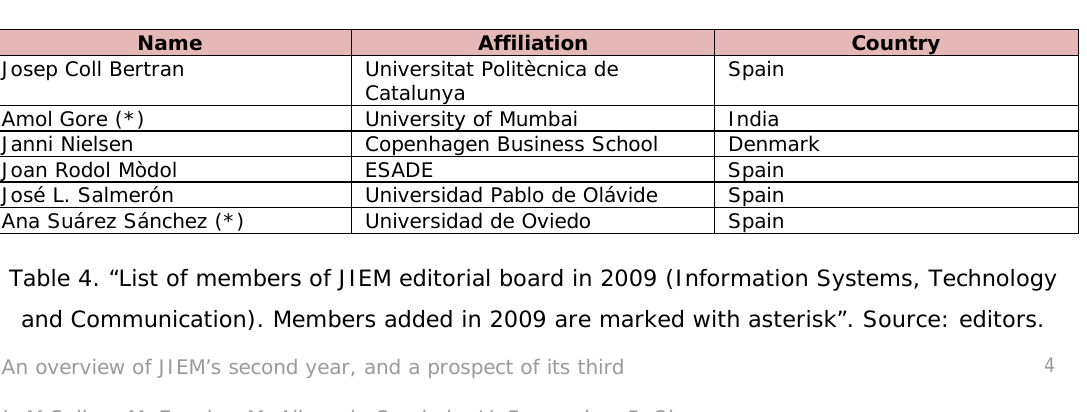
Table 3. “List of members of JIEM editorial board in 2009 (Production, Logistics, Quality and Operational Research). Members added in 2009 are marked with asterisk”. Source: editors.